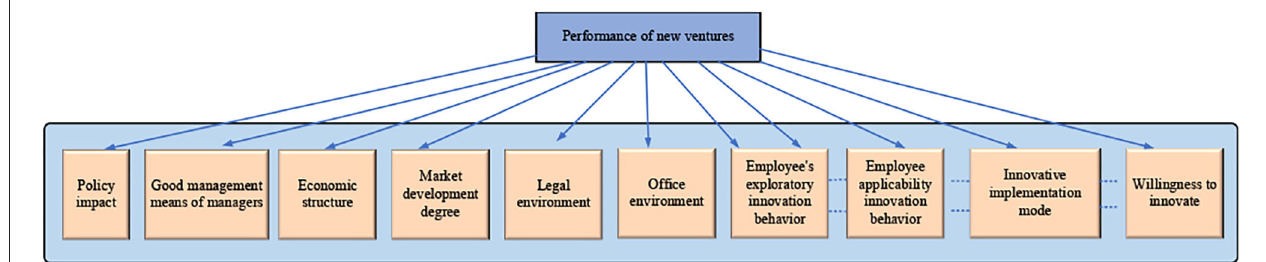
FIGURE 1 | The conceptual model of influencing factors.